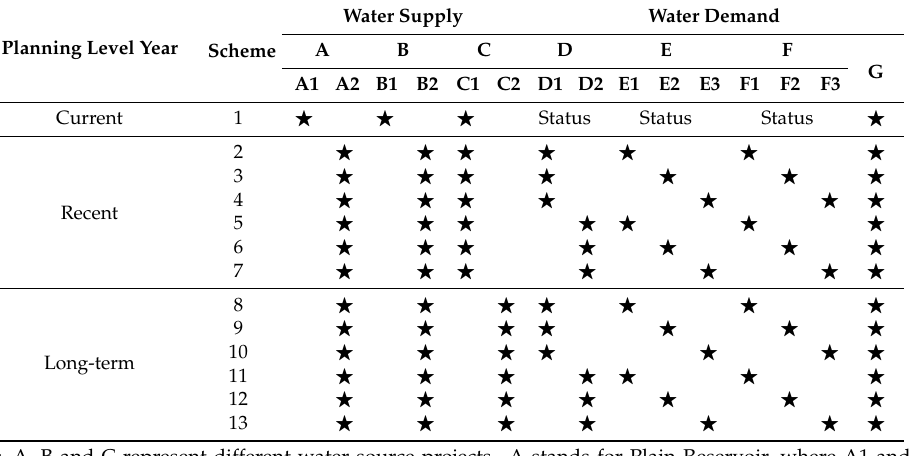
Table 3. The scheme set for water resource allocation in the Heihe River